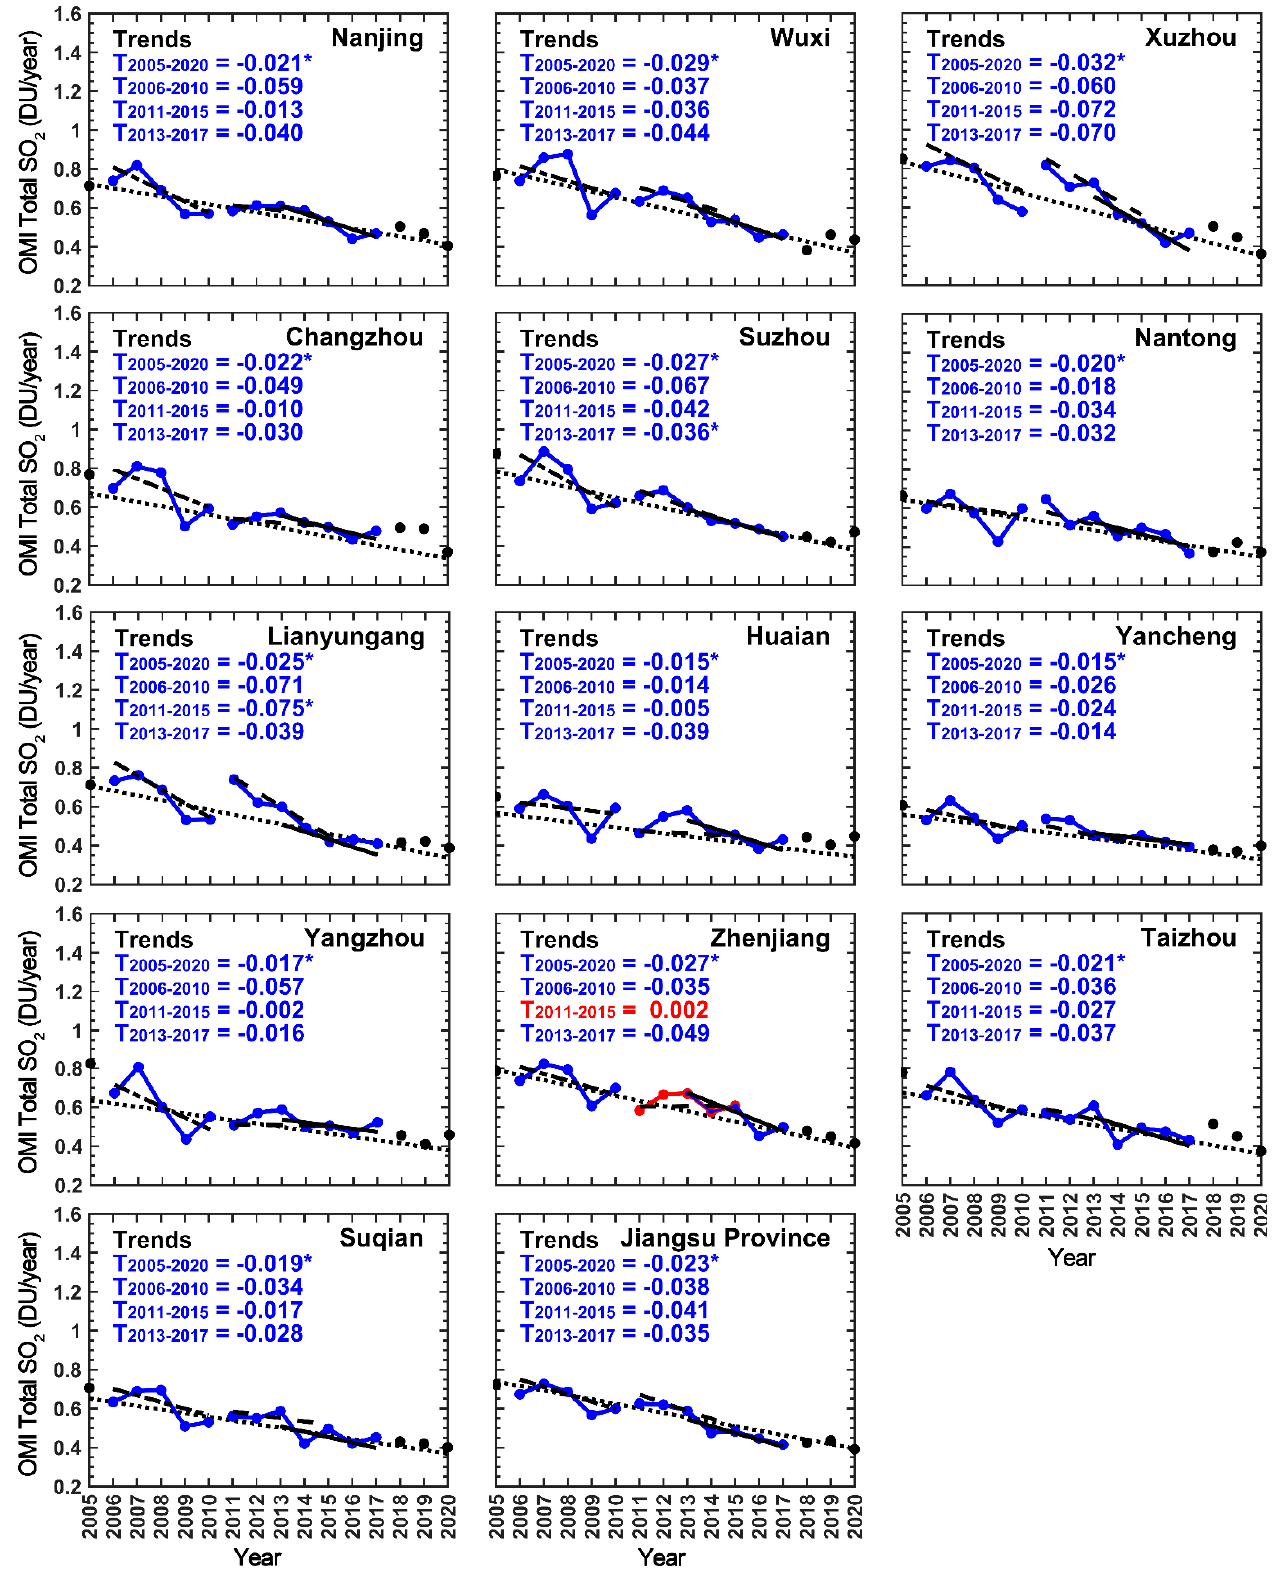
Figure 9. Trends in SO 2 (DU/year) for the periods of 2005 − 2020, 2006 − 2010, 2011 − 2015, and 2013 − 2017 in 13 cities of Jiangsu Province. The red color indicates an increasing trend, and the blue color indicates a decreasing trend in SO 2 . The asterisk (*) indicates significance.